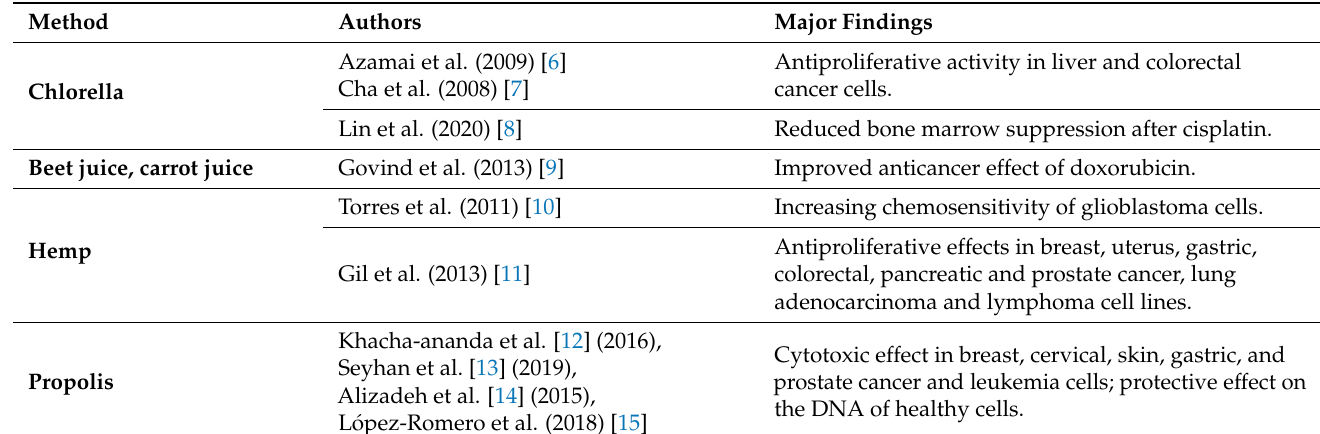
Table 1. Animal and in vitro